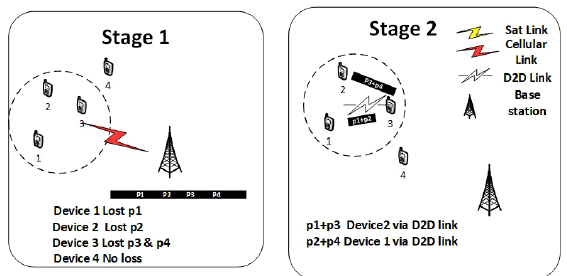
Figure 3. Network coding (D2D only).